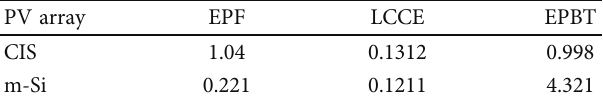
Table 12: PV system ’ s energy metrics.